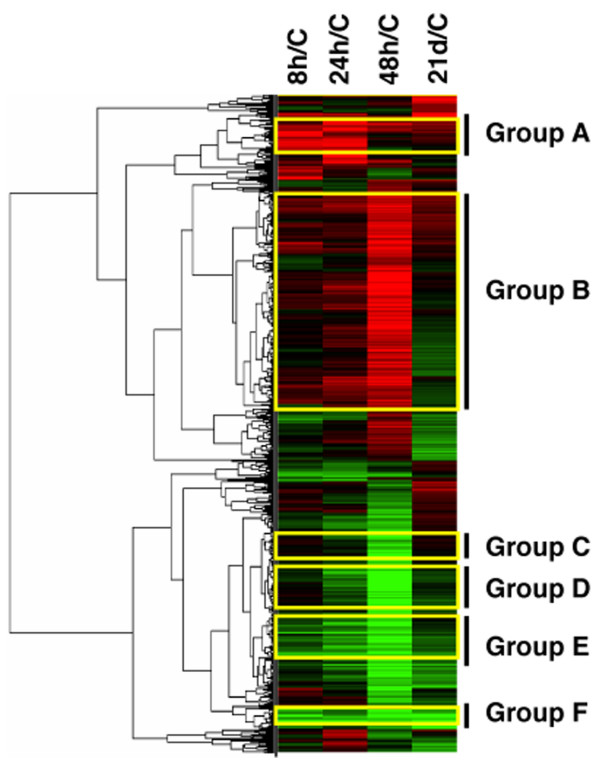
Hierarchical clustering analysis of 1,853 genes from Affymetrix array analysis showing differential expression patterns during S. Choleraesuis infection. Differential expression criteria: p-value < 0.01, estimated FC > 2, q < 0.26. The heat map was built by using Gene Cluster 3.0 software. Red color represents down-regulation and green shows up-regulation.